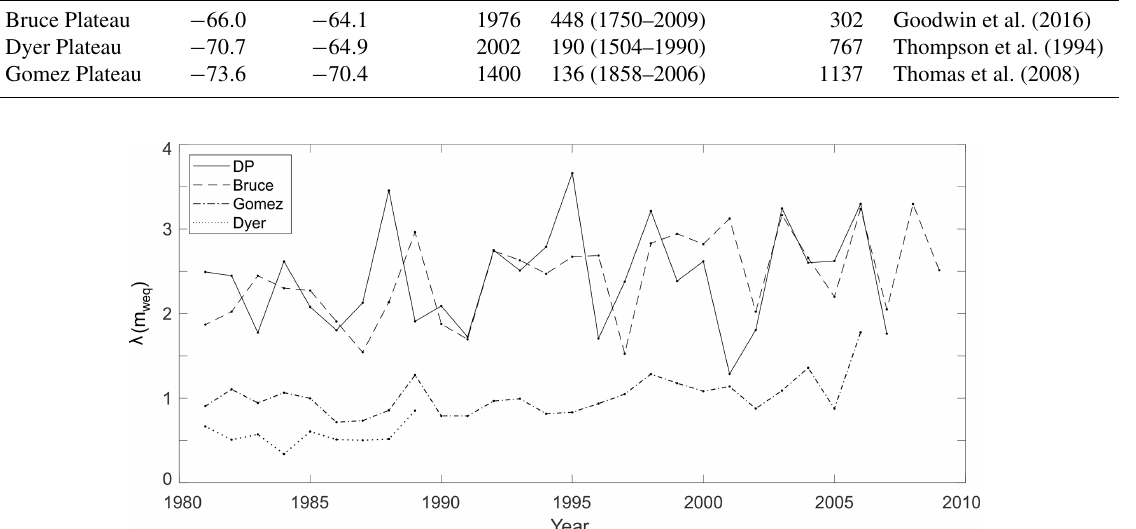
Figure 6. Annual snow accumulation in ice cores from the DP (solid line), Bruce Plateau (dashed line), Gomez Plateau (dash-dotted line) and Dyer Plateau (dotted line) for the period